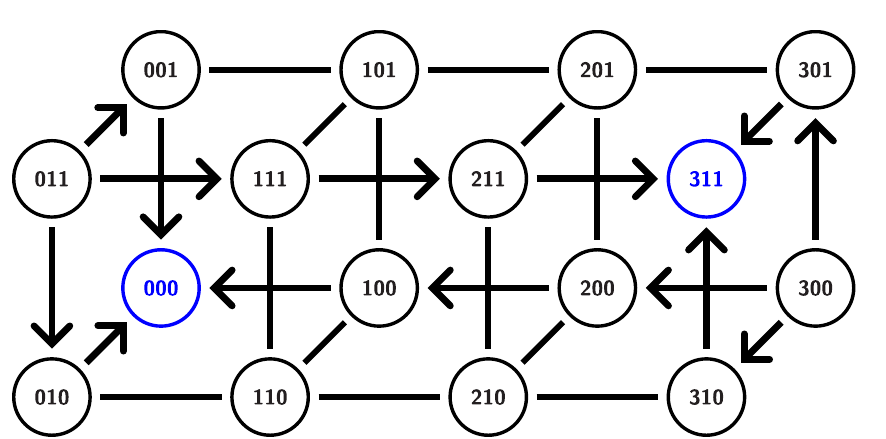
Fig 7. STG for network 6 from Fig 3. Since node 0 has three output edges there are three thresholds of the variable corresponding to 0 and four states 0,1,2,3. The arrows are valid for any essential parameter nodes in PG . The direction of other, un-oriented edges, depends on a choice of a particular essential node in PG (0). Since the bistabilty between (000) and (311) is assured for any such choice resulting in lack of fragility of the bistablty and